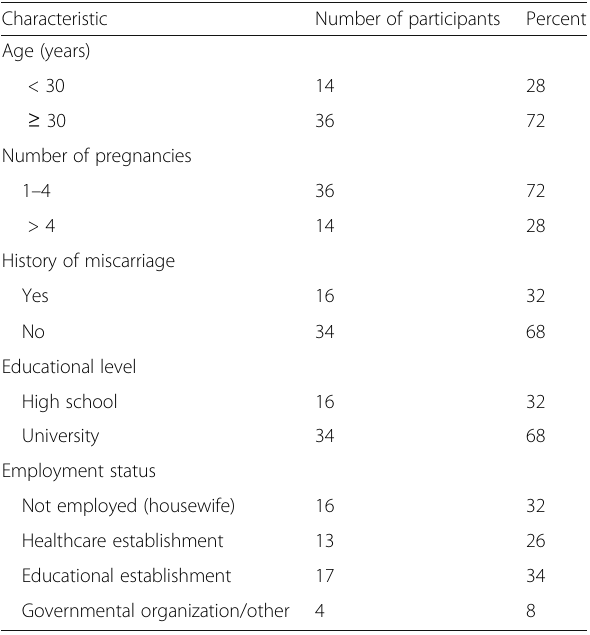
Table 2 Sociodemographic characteristics of the women